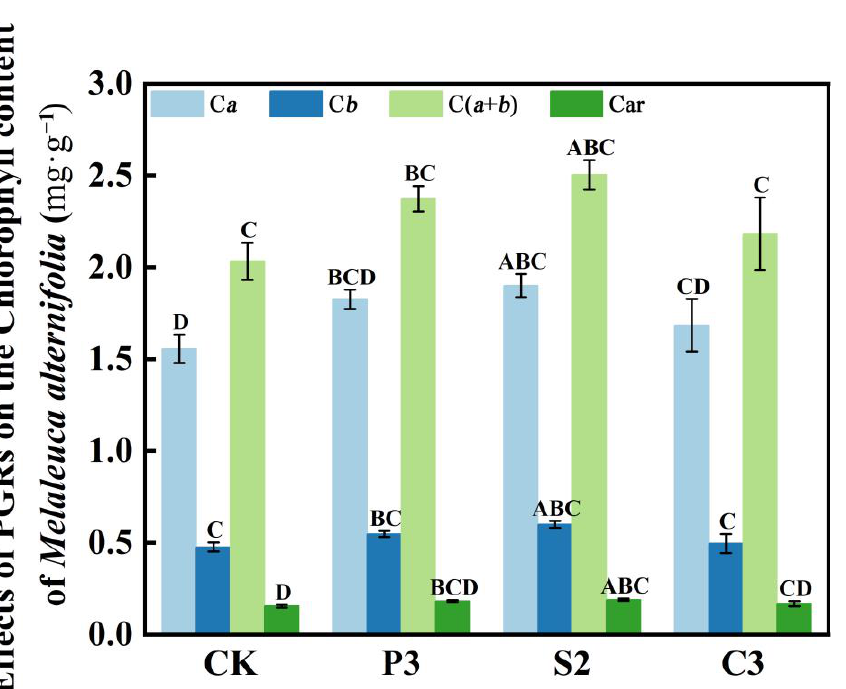
Figure 3. Effects of three PGRs on the chlorophyll content of M. alternifolia. Note: different letters followed the mean indicate significance at p < 0.01 according to Duncan’s multiple range test.